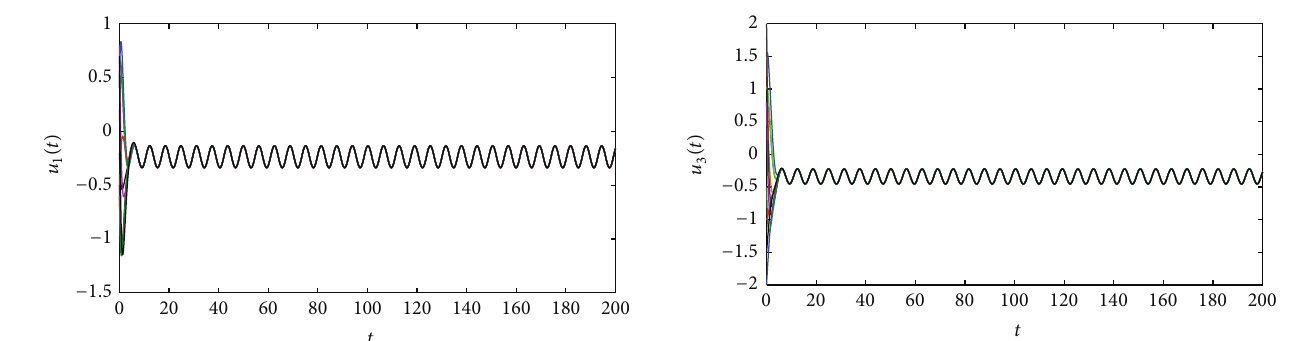
Figure 3: Transient response of state variables 𝑢 3 (𝑡) of Example 1.